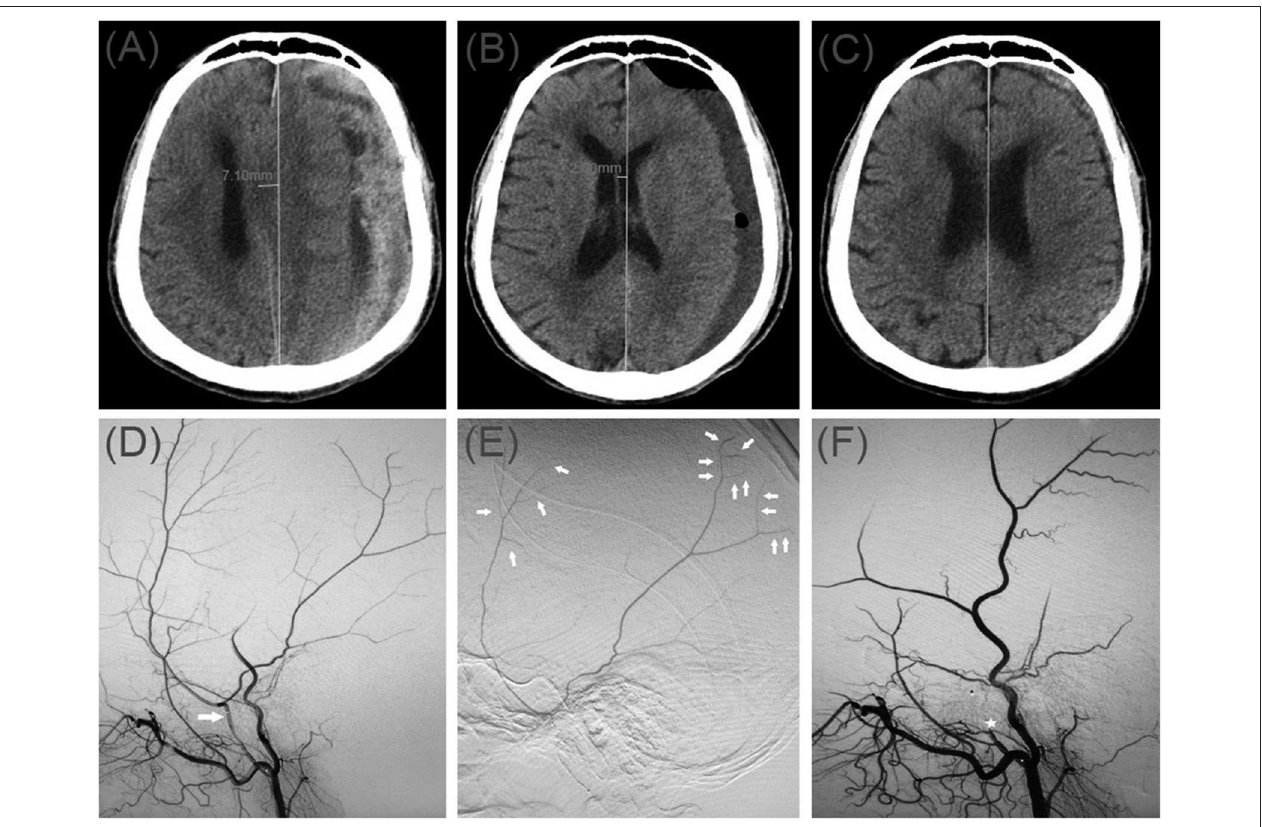
FIGURE 4 | (A) Brain computed tomographic hematoma images for patient 4 before treatment (midline shift: 7.10mm). (B) Brain CT was repeated on postoperative day 14 (midline shift: 2.00mm). (C) Follow-up brain CT was performed at 72 days. (D) Pre-operative DSA presented abnormal MMA (Large arrow). (E) Intra-operative DSA showed contrast agent extravasation or cotton wool-like staining (Small arrow). (F) Postoperative DSA found that the MMA disappeared